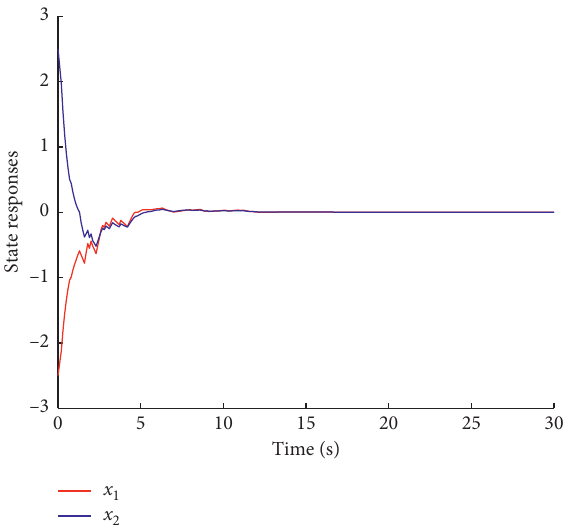
Figure 10: The state response in Case 4.